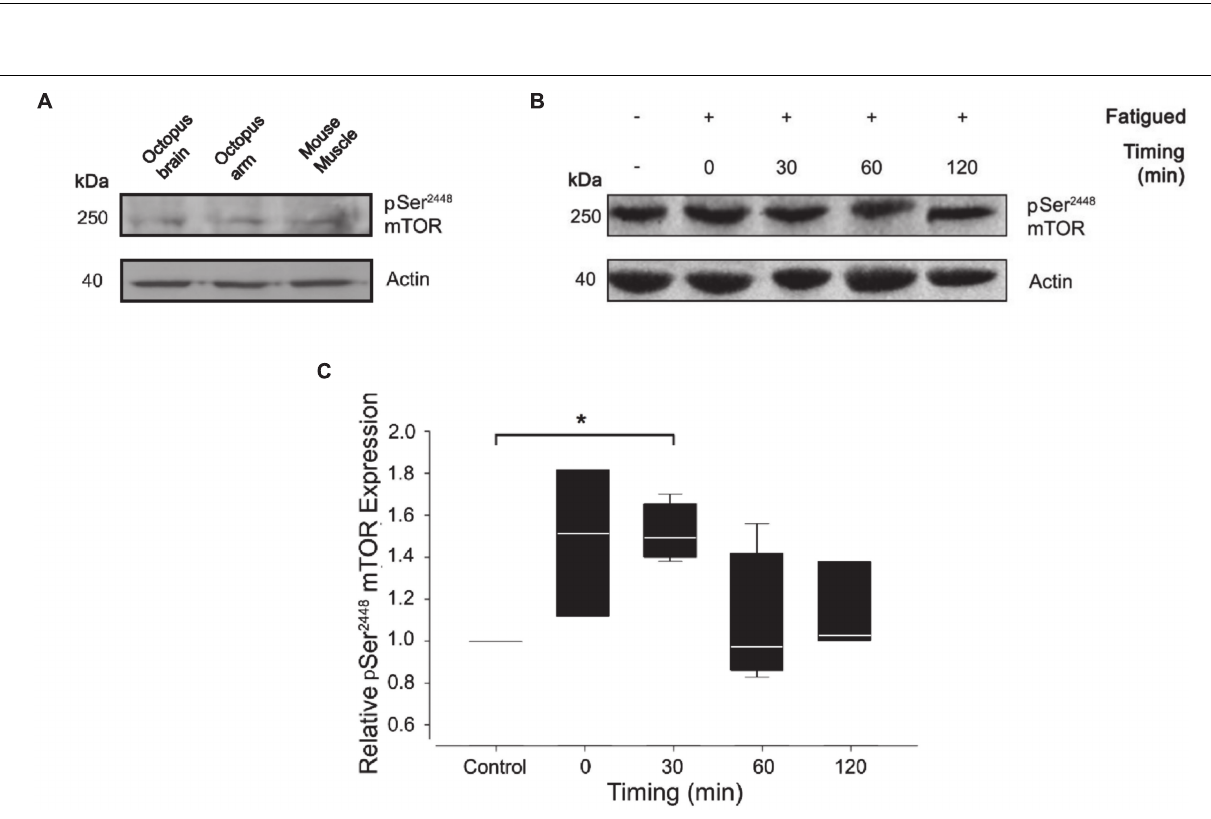
Frontiers in Physiology |